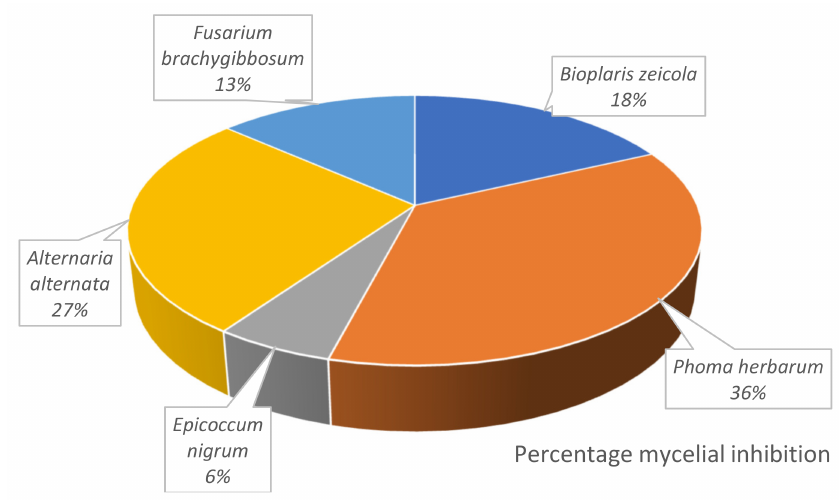
Figure 6. Pie chart showing the pooled effect of the nanoparticles on the percentage mycelial inhibition.